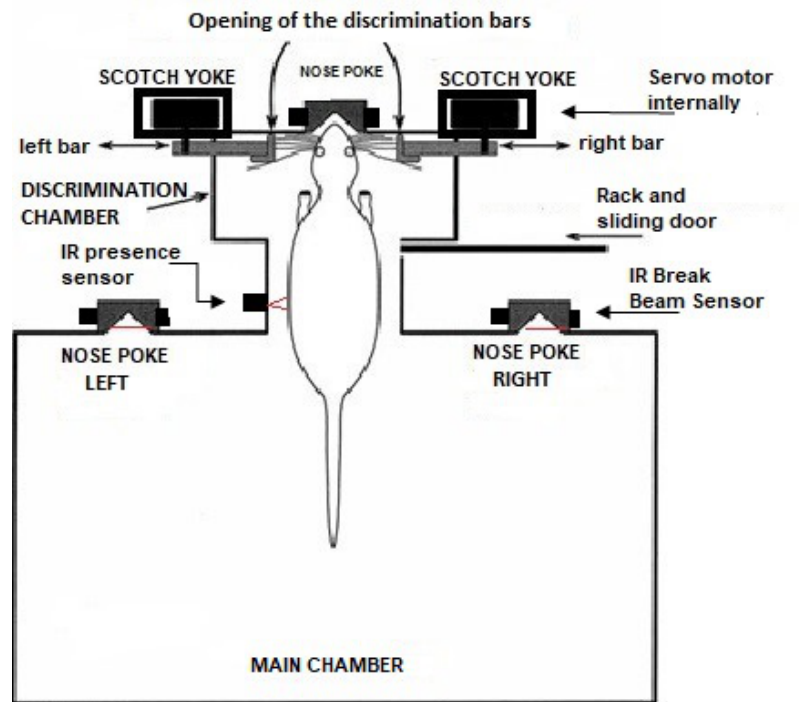
Figure 2. Behavioral box schematic without the extra training bars, with a rat in the discrimination chamber illustrating its